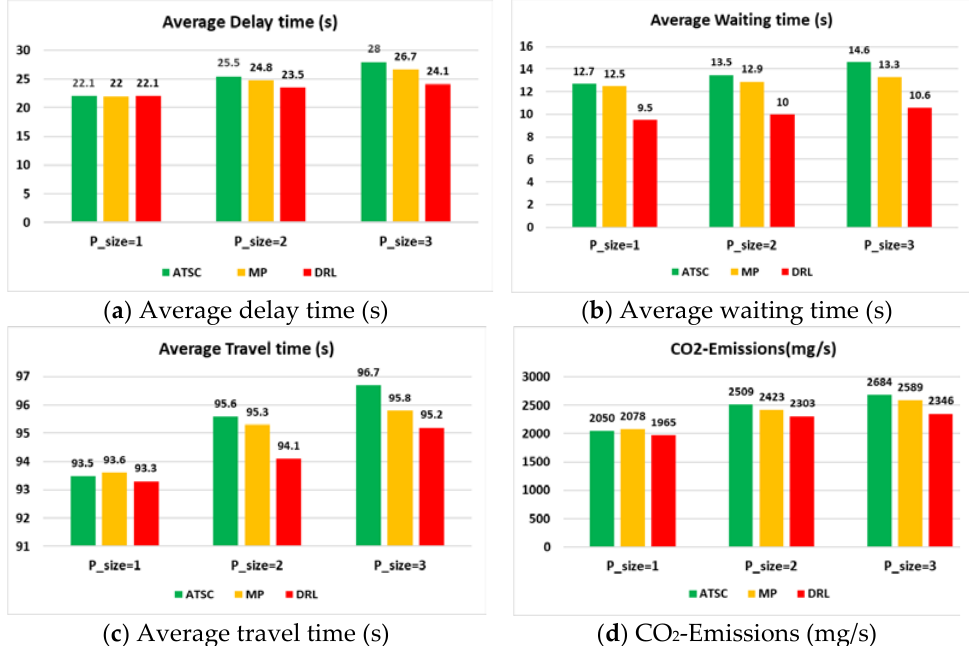
Figure 13. Results of MOE evaluation.